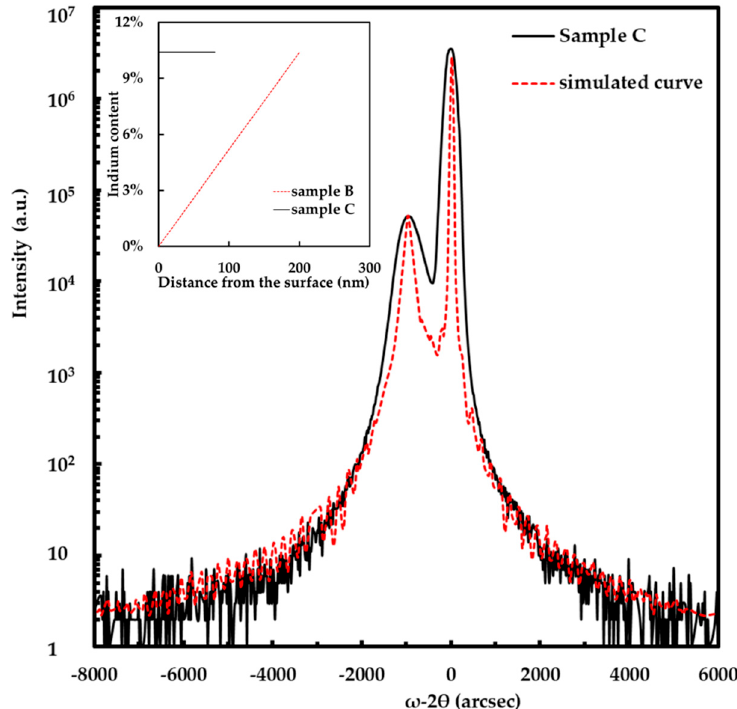
Figure 2. High-resolution X-ray diffraction ω -2 θ scan of sample C. The dashed line in red is the simulated curve. The inset shows the indium content profiles of samples B and C.